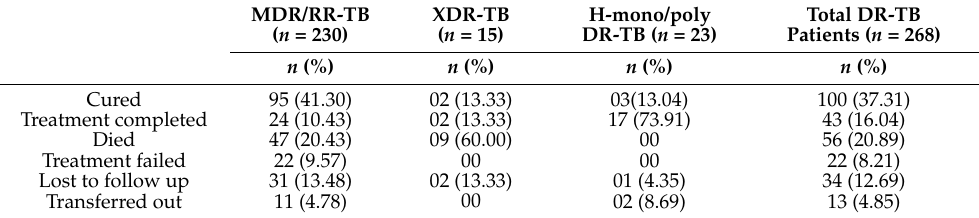
Table 3. Final treatment outcome of drug-resistant pulmonary tuberculosis patients ( n = 268).